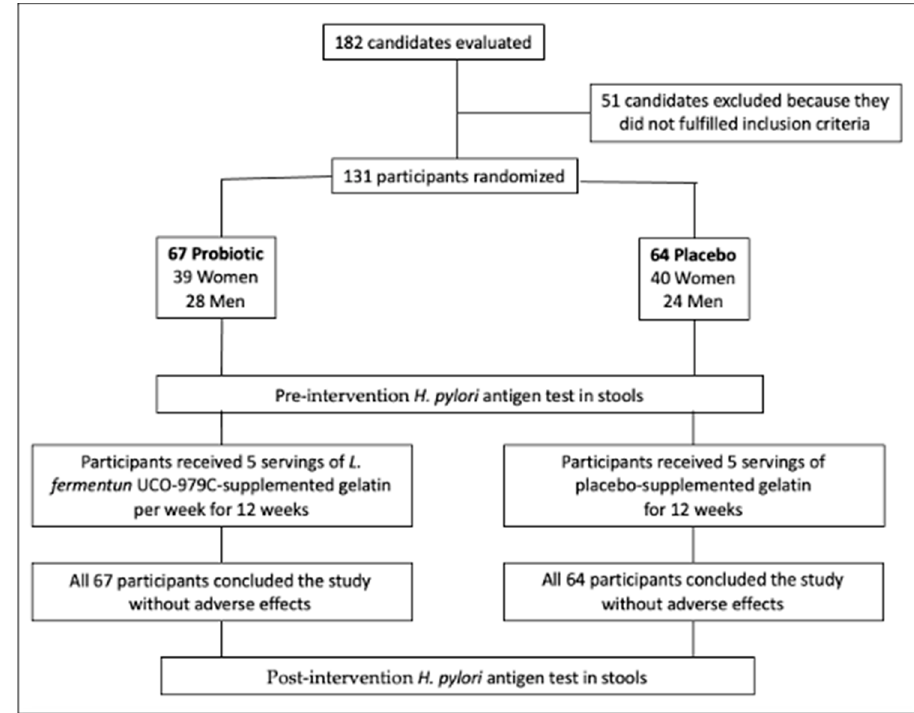
Figure 1. CONSORT flow diagram of recruitment and analysis of participants.